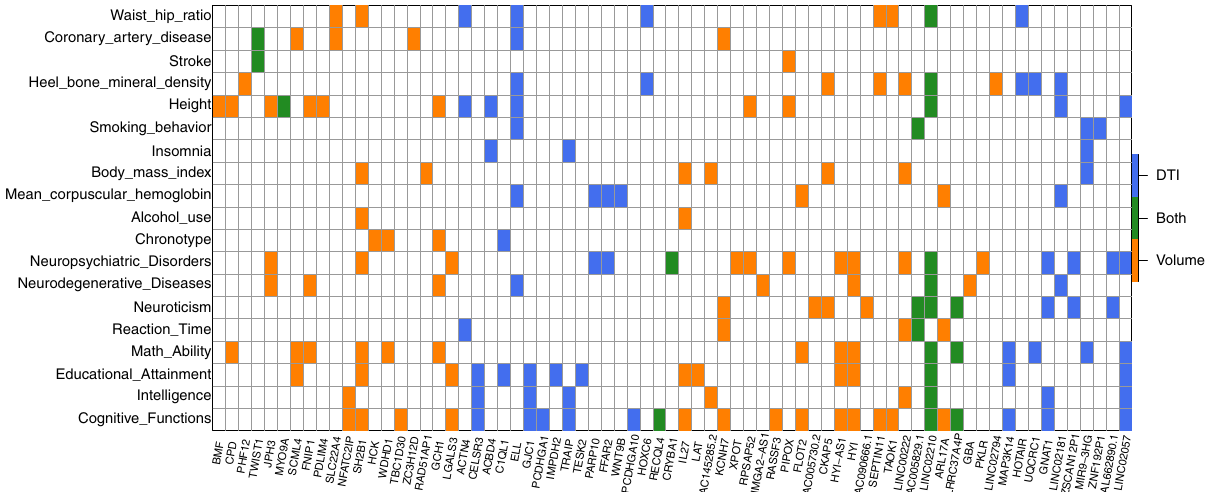
Fig. 2 Cross-tissue TWAS-signi fi cant genes of neuroimaging traits ( n = 19,629 subjects for ROI volumes and 17,706 for DTI parameters) that have been linked to other complex traits in previous GWAS. For each of the cross-tissue TWAS-signi fi cant genes listed in the x axis, we manually checked the previously reported associations on the NHGRI-EBI GWAS catalog (https://www.ebi.ac.uk/gwas/). The genes associated with DTI parameters (DTI), ROI volumes (volume), and both of them (Both) were labeled with three different colors (blue, orange, and green,